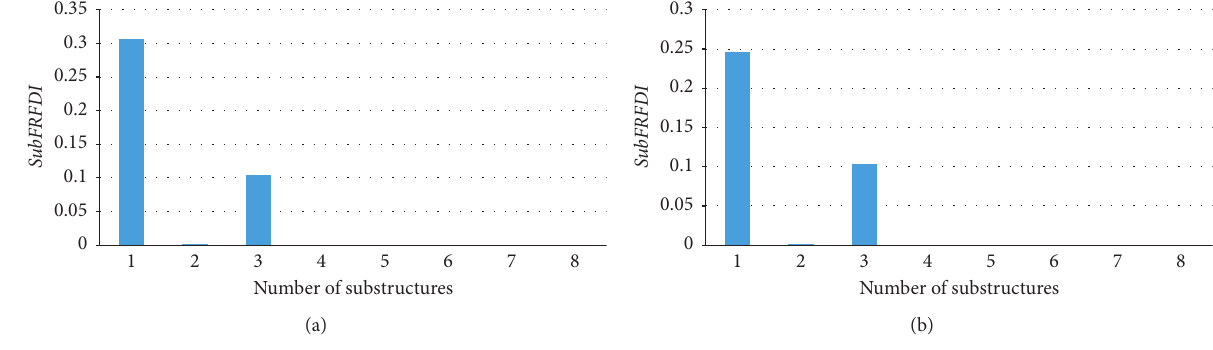
Figure 33: SubFRFDI values of DIC-measured data for (a) case Dam200_1F&3F and (b) case